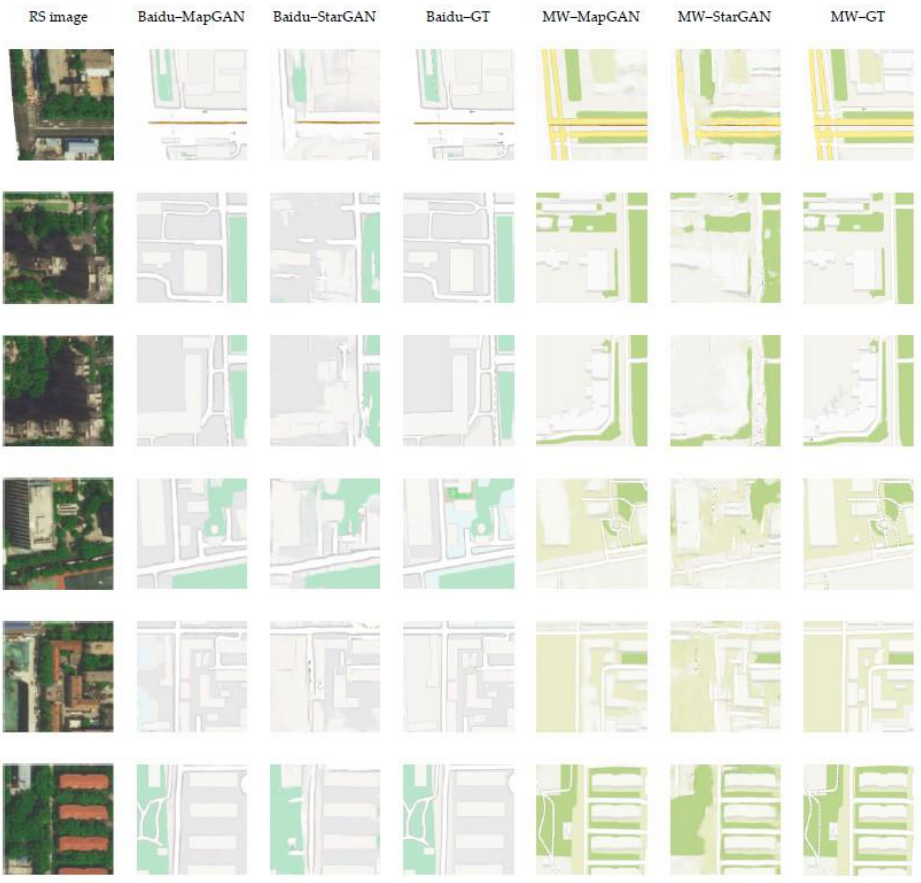
Figure 11. Comparison results of the Baidu and Map World electronic maps generated by MapGAN and StarGAN in the one-to-many map generation experiment. The images from left to right are remote sensing images, the Baidu maps generated by MapGAN and StarGAN, the real Baidu maps, the Map World maps generated by MapGAN and StarGAN, and the real Map World maps.